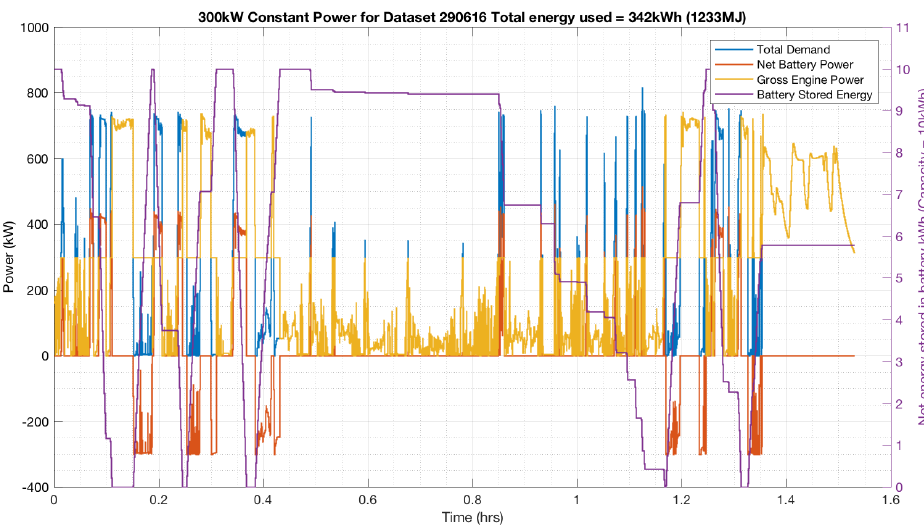
Figure 18. Battery operation under full cycle